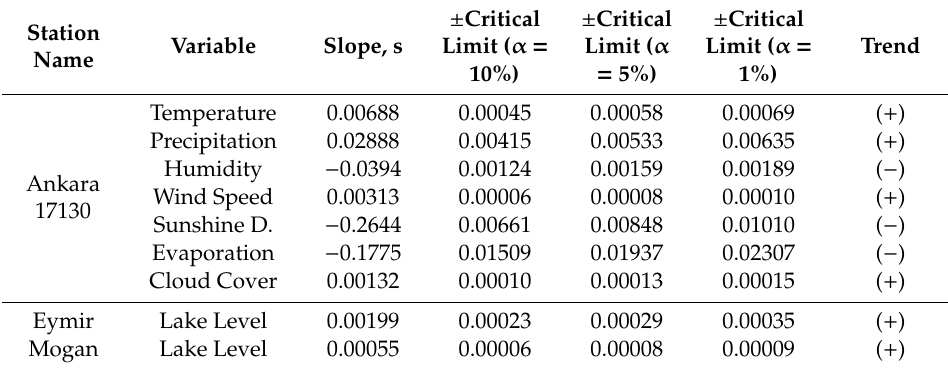
Table 6. ST method results.